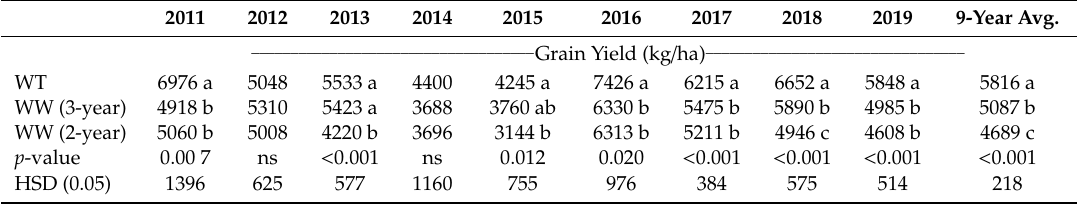
Table 4. Grain yield of winter triticale (WT) and 3-year and 2-year winter wheat (WW) for nine years and averaged over years at Ritzville, WA. Within-year letters followed by a di ff erent letter are significantly di ff erent. ns = not